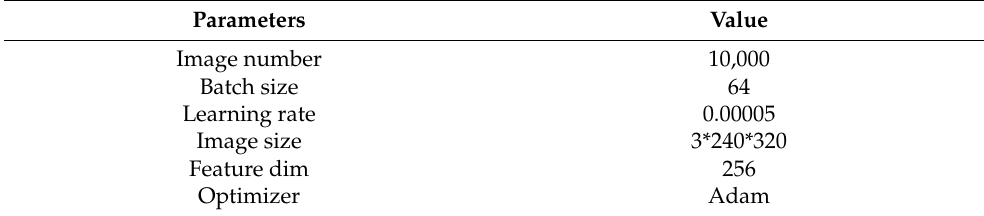
Table 7. Hyperparameters of Training the Encoder.